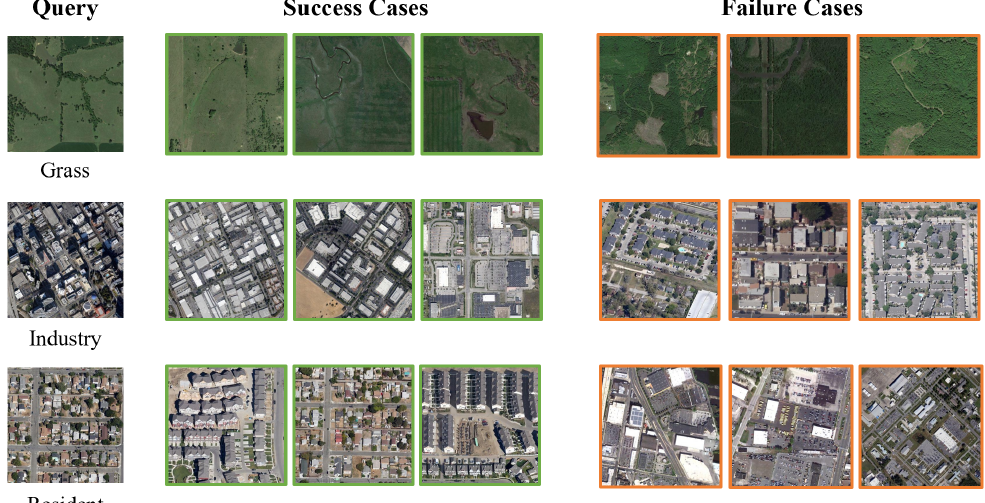
Figure 15. Examples of RSSCN7 retrieval results. Column 1 is the query sample, columns 2–4 are the success cases of our method, and columns 5–7 are the failure cases.